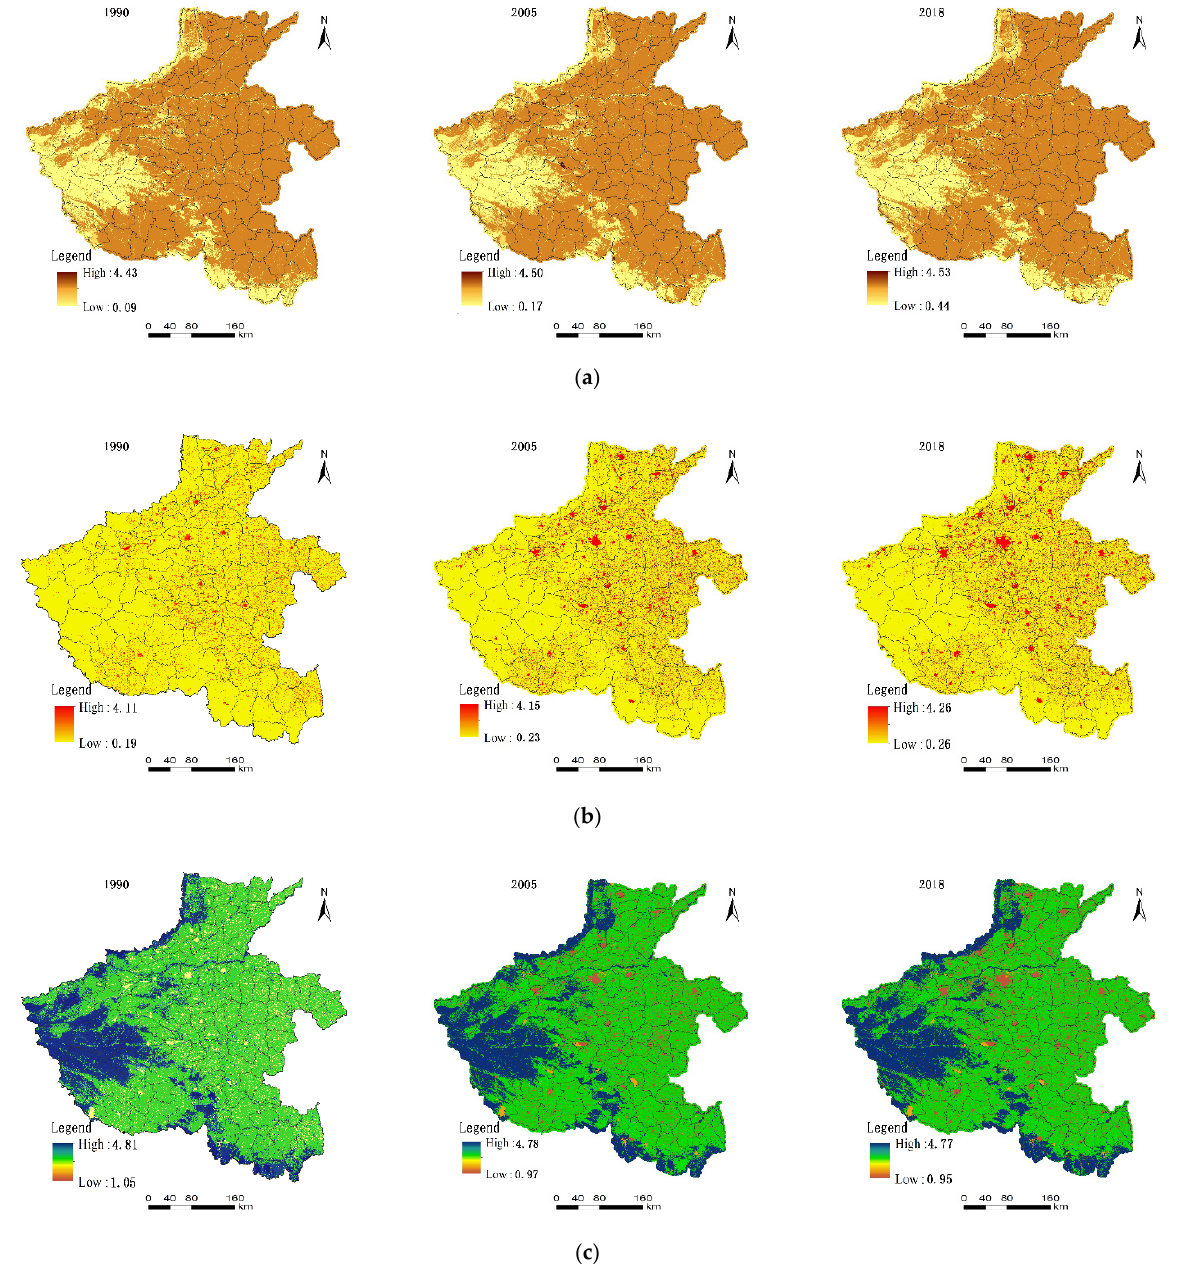
Figure 3. Function evaluation value of territorial space of Henan Province. ( a ) Function evaluation value of production; ( b ) function evaluation value of living; and ( c ) function evaluation value of ecological.